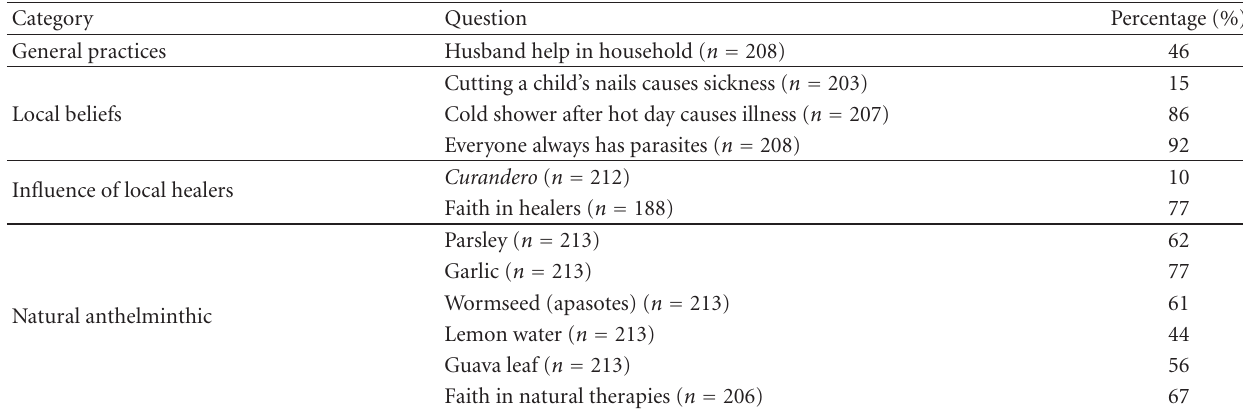
Table 3: Cultural factors associated with parasites.